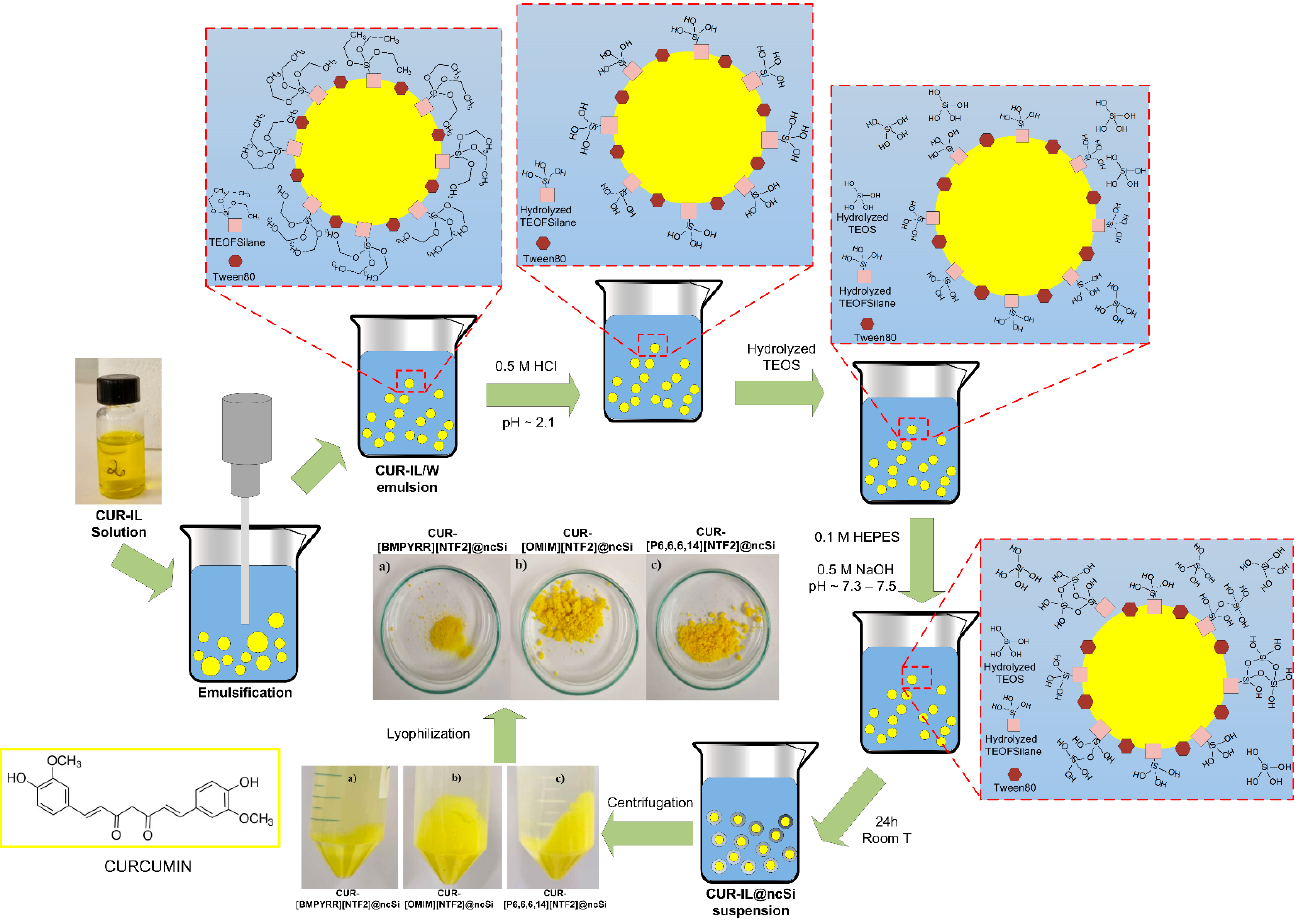
Figure 1. Schematic representation of the nanocapsule preparation process. Inserted pictures: ( a ) CUR-[BMPYRR][NTf 2 ]@ncSi; ( b ) CUR-[OMIM][NTf 2 ]@ncSi; and ( c ) CUR-[P 6,6,6,14 ][NTf 2